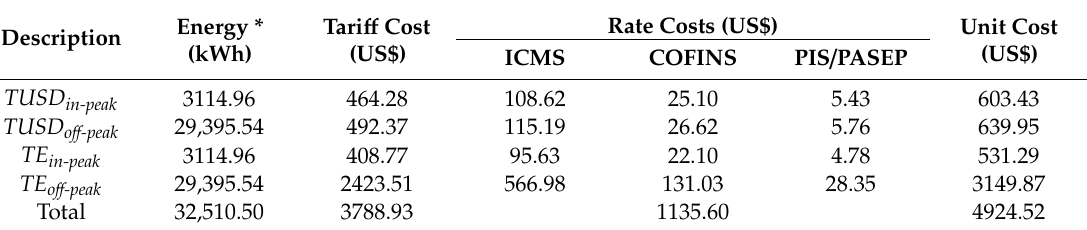
Table 2. Costs according to the White Tari ff for Sorocaba Technology Park.